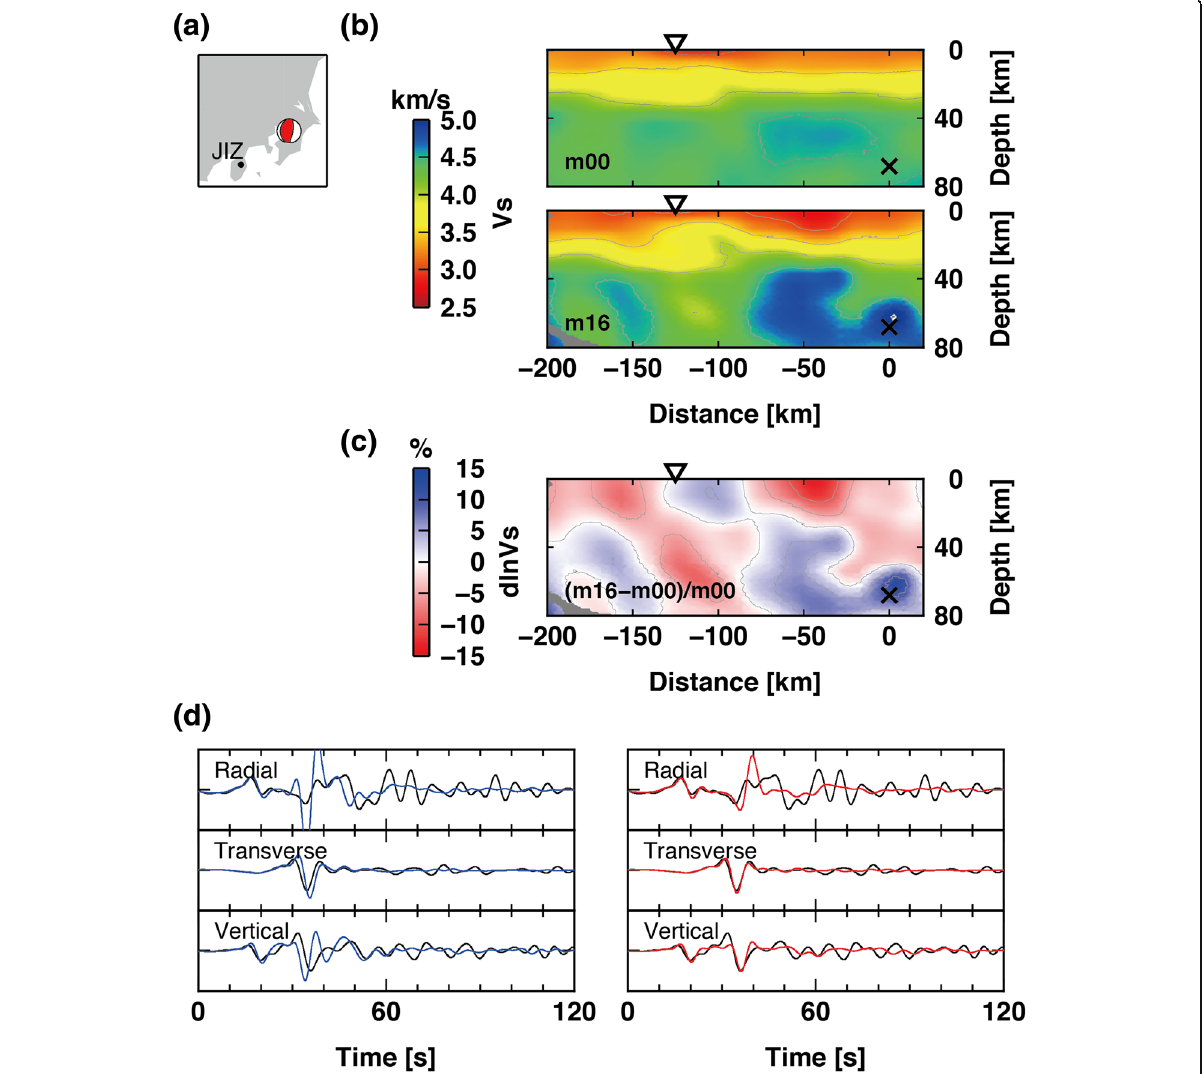
Fig. 9 Same as Fig. 8 for the wave speed models and waveforms for the earthquake on the PAC (May 13, 2014; M W 5.0). a Source and receiver. b Vertical cross section of V s for m 00 and m 16 . c Vertical cross section of the difference between the V s values for m 00 and m 16 . d Waveform comparisons. The gray areas in ( b ) and ( c ) indicate areas of low data coverage. The crosses and inverted triangles in ( b ) and ( c ) show the location of the earthquake and station in ( a ), respectively. The black, blue, and red lines in ( d ) indicate the observed, m 00 , and m 16 waveforms,